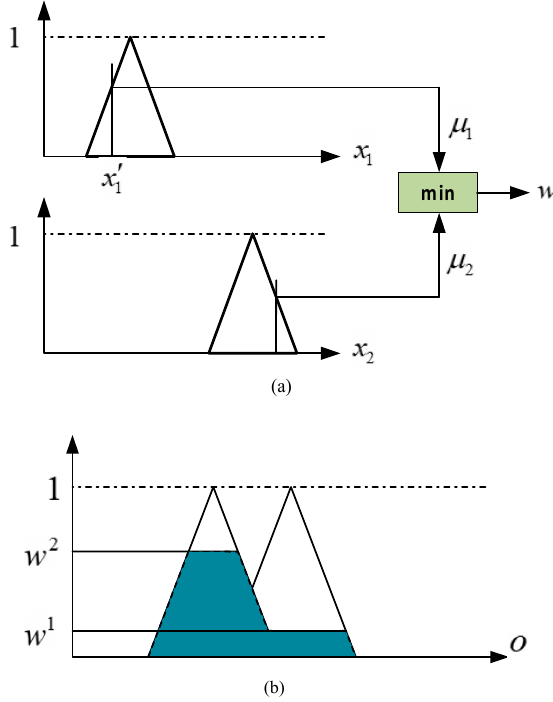
Figure 2. Type-1 fuzzy inference mechanism: ( a ) antecedent logical implication and ( b ) aggregated consequent set for two-rule evaluation.